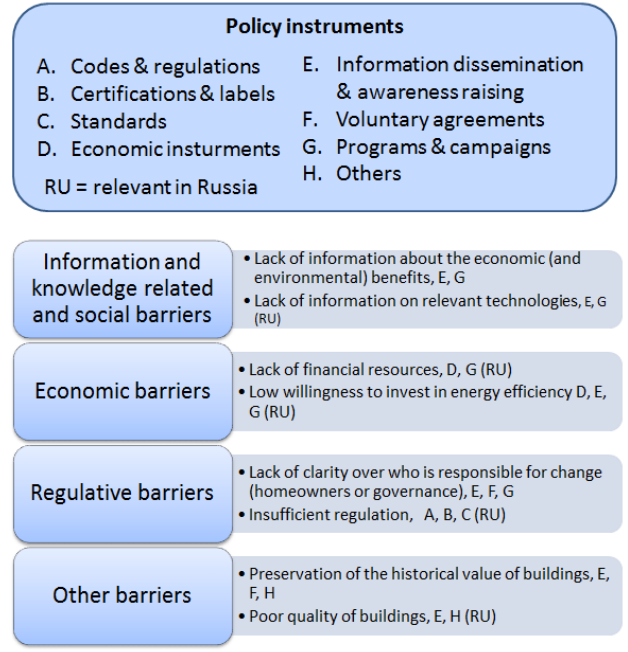
Figure 8. Barriers for energy efficiency and applicable policy instruments in the Russian context.